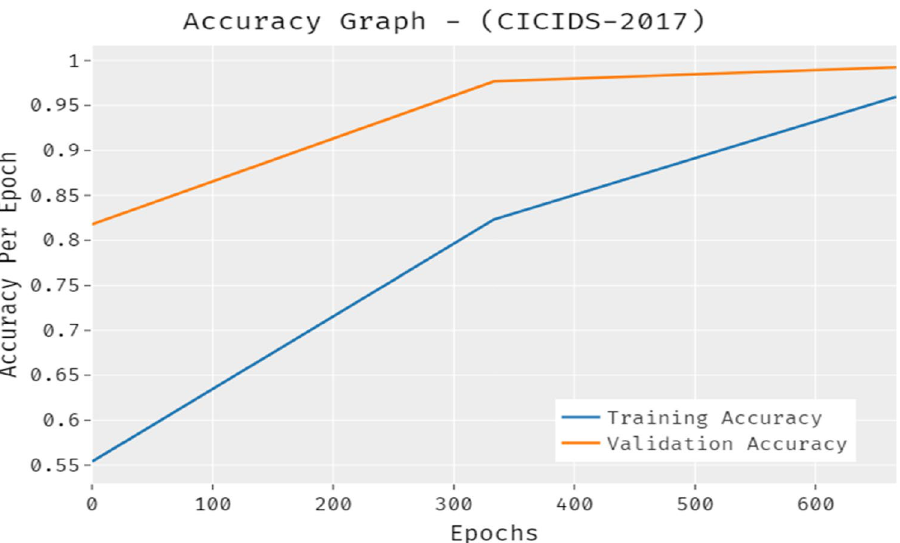
Figure 10. Accuracy analysis of PRO-DLBIDCPS technique CICIDS-2017